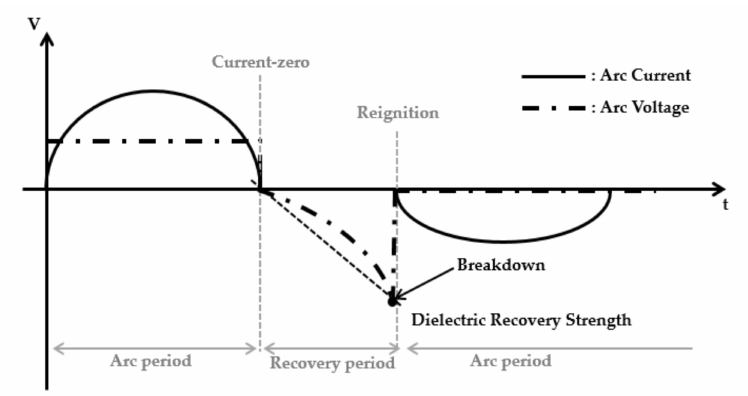
Figure 1. Schematic diagram of dielectric recovery strength.